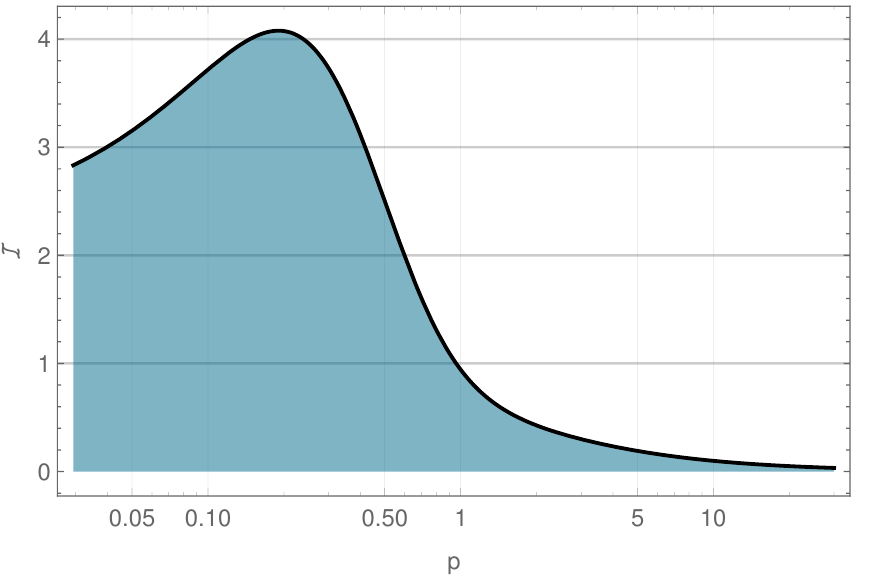
Figure 2 . The full integrand in (5.32) obtained by combining numerical results for the fermionic phase shifts and the analytic expression for the bosonic phase shift. We have set the parameter h = 1 in this figure. The integral over the shaded region gives us the regularized Γ K